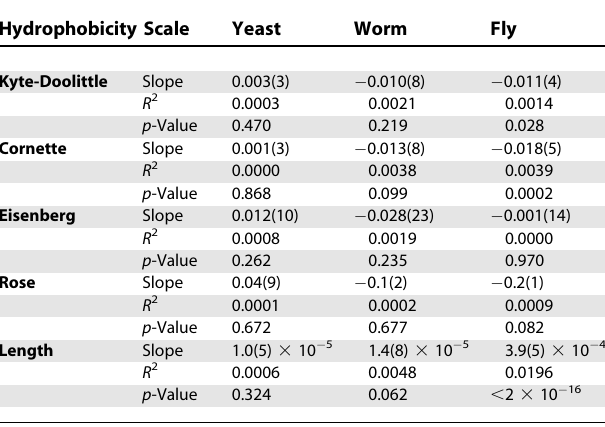
Table 6. Correlation of False-Discovery Rates with Hydro- phobicity Scales and Length Hydrophobicity